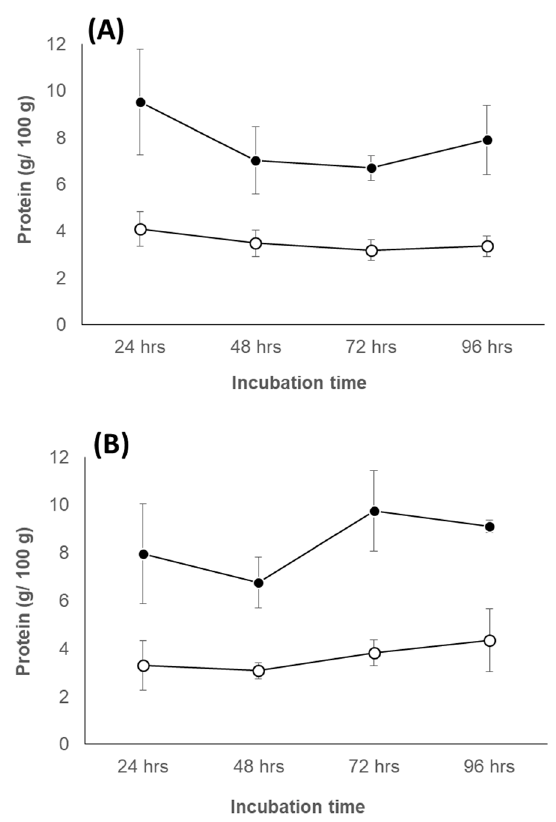
Figure 7. Change of protein concentrations in the mixtures of masu salmon reacted at 55 °C ( A ) and 60 °C ( B ) for 96 h. Closed circle ( ● ), without water; open circle (o) with water. Values show average ± standard deviation ( n = 3).